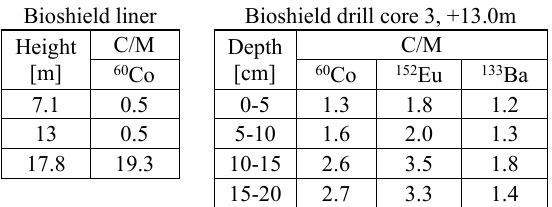
Table 2. Drywell Activation Validation